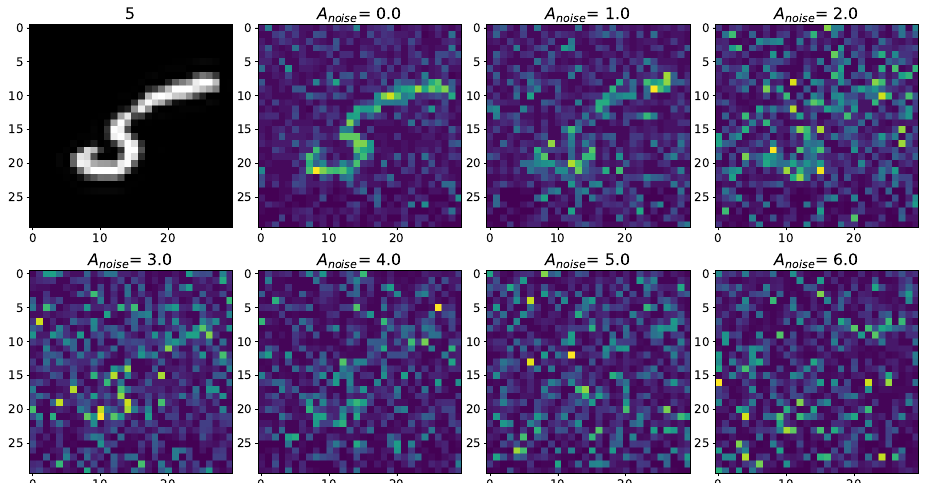
Figure A5. The middle picture is the supplied pattern (5 from handwritten database MNIST (MNIST dataset is made available under the terms of the Creative Commons Attribution-Share Alike 3.0 license)) [39], on the left, encoded by the spiking neural network without astrocyte modulation and noise amplitude A noise = 6, and on the right, with astrocyte modulation and noise amplitude A noise = 6.